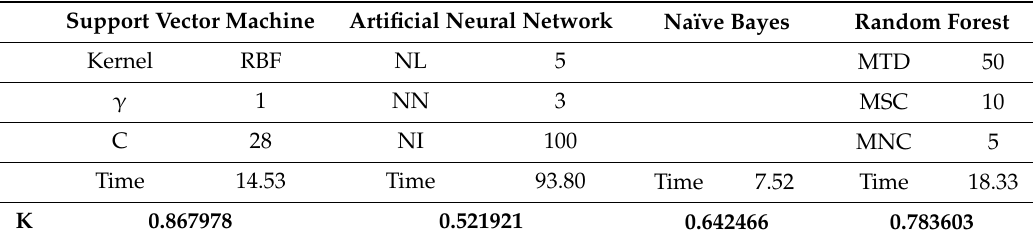
Table 13. Overall performance with the best combination of each model for Varaždin. Support Vector Machine Artificial Neural Network Naïve Bayes Random Forest Kernel